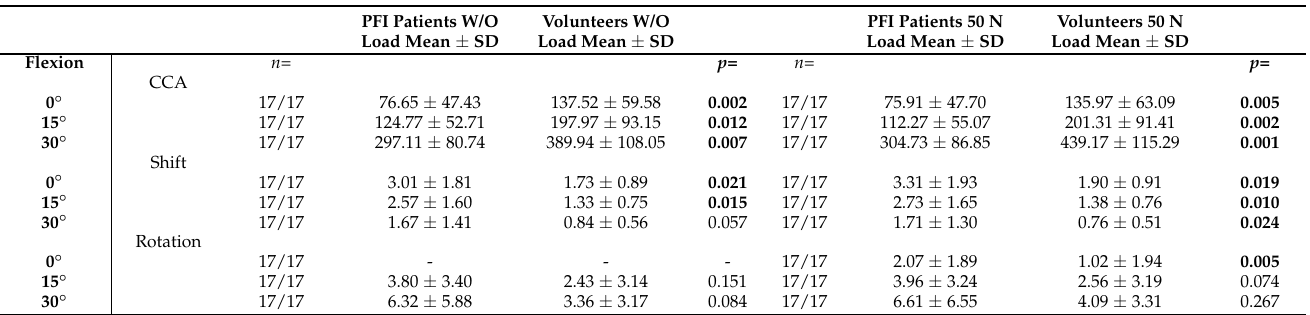
Table 2. Overview of measured parameters (mm 2 ) of patients and volunteers in unloaded and loaded